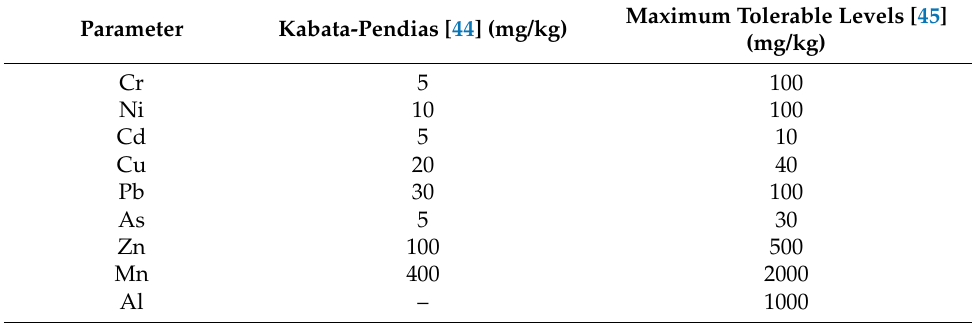
Table 3. Recommended levels of nine potentially toxic elements.